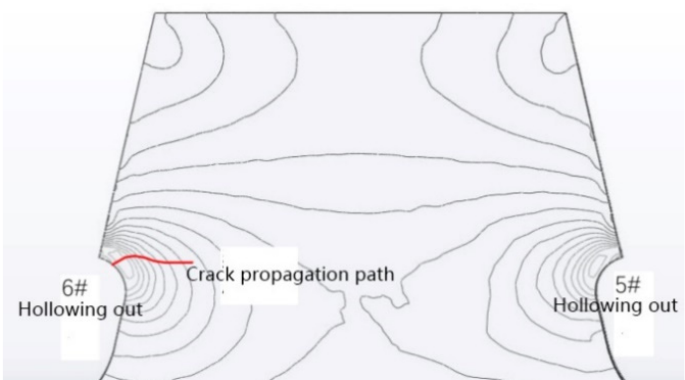
Figure 7. Contour of principal stress and crack-propagation path on the right side of 6# arc opening.